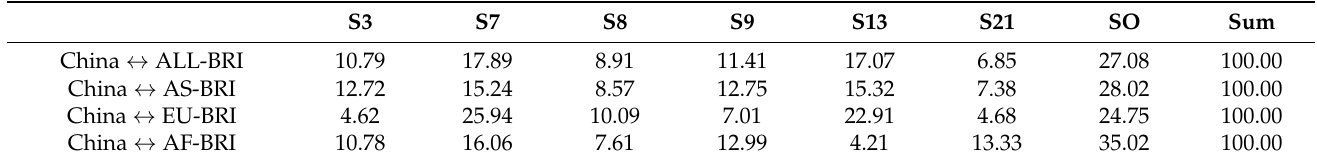
Table 3. Sectoral share of economic spillovers between China and BRI countries